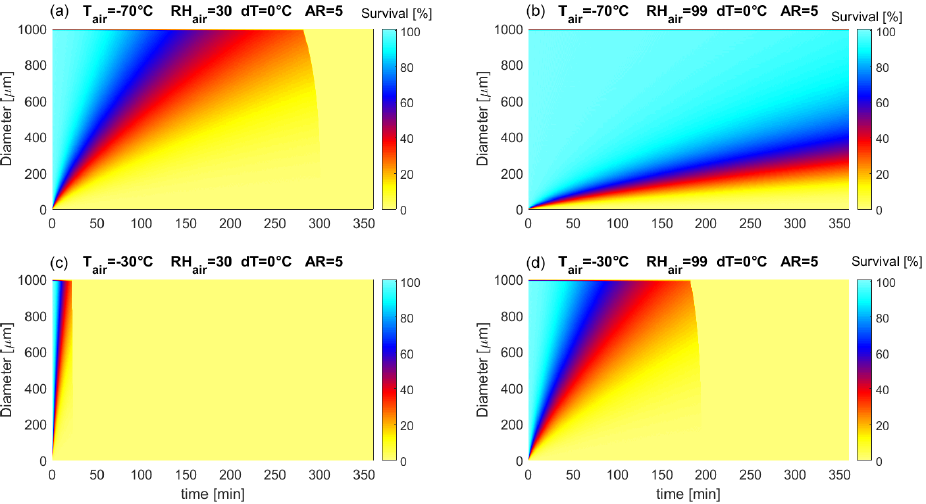
Figure 10. Evolution of an originally uniform PSD of ice spheroids ( D = 0–2000µm, AR = 5) under different atmospheric conditions. The DS (or “bench”) is in thermal equilibrium with air (d T = 0). (a, b) Winter, (c, d)